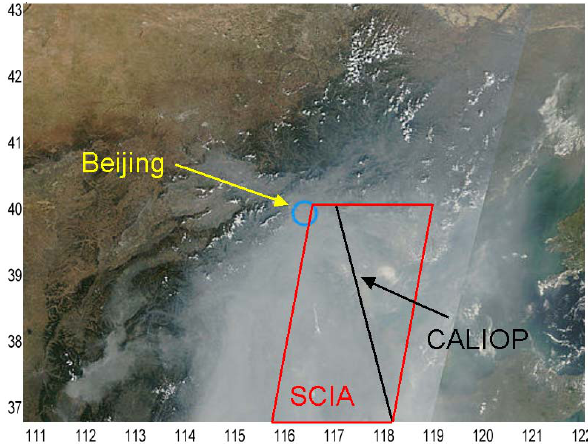
Fig. 14. MODIS RGB image for a day with strong aerosol pollu- Fig. 14 MODIS RGB image for a day with strong aerosol pollution (September 16, 2006) tion (16 September 2006) over the area around over Beijing (AOD over the area around over Beijing (AOD between 2 and 3). Near-simultaneous CALIOP between 2 and 3). Near-simultaneous CALIOP measurements in- measurements indicate that the aerosol layer height between about 40° N and 37°N increased dicate that the aerosol layer height between about 40 ◦ N and 37 ◦ N from about 1 km to 2.5 km. increased from about 1km to